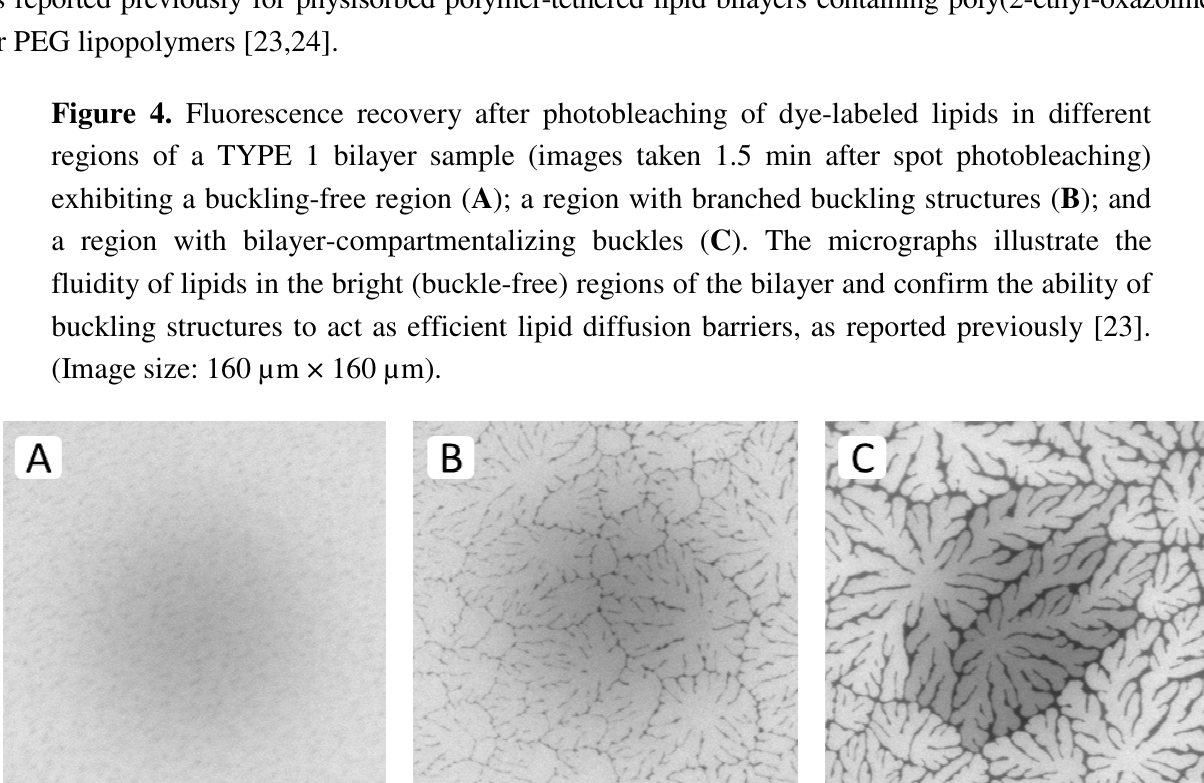
Figure 4. Fluorescence recovery after photobleaching of dye regions of a TYPE 1